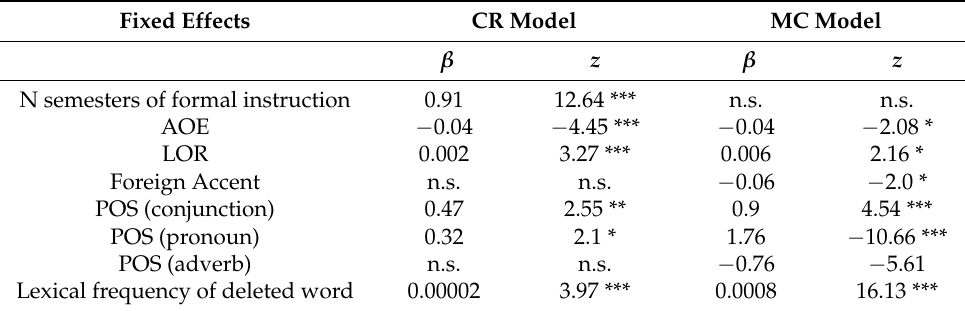
Table 7. Significant main effects obtained in multivariate logistic analyses of cloze test